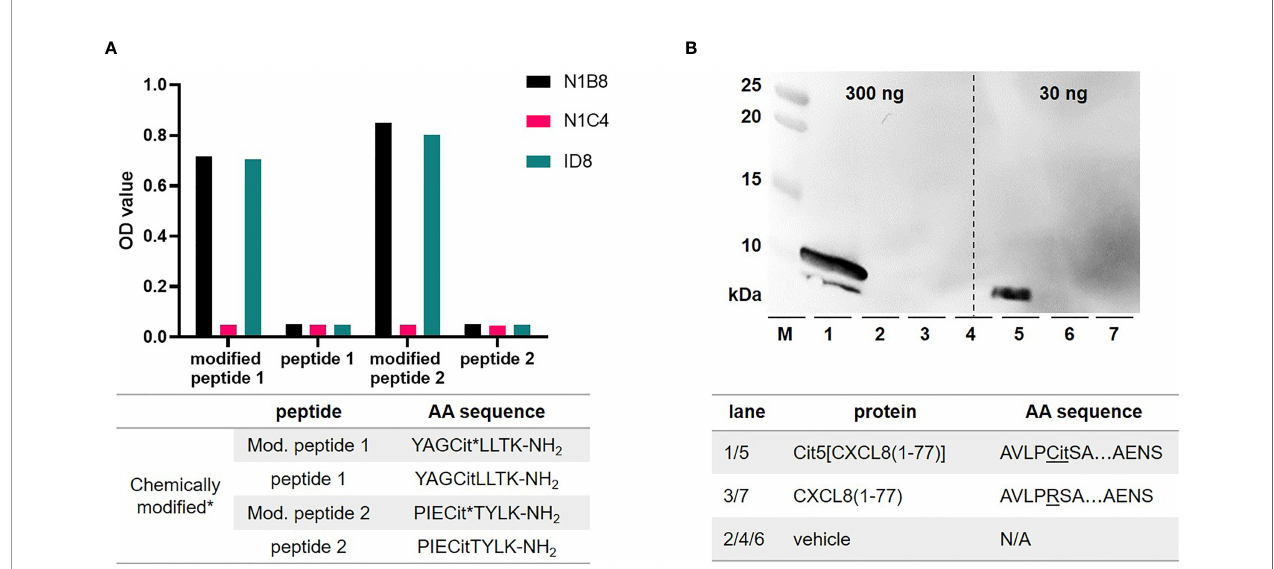
FIGURE 2 | Production and validation of monoclonal anti-modi fi ed citrulline antibodies. Hybridoma clones, both generated from modi fi ed peptide 2, were screened with ELISAs, reactive towards different synthetic citrulline (Cit) containing peptides. These were chemically modi fi ed (* asterisk), and their unmodi fi ed isoforms served as negative controls (A) . Puri fi ed monoclonal antibodies were validated with in-house CXCL8 isoforms. By Western Blot analysis and a protein marker (M) we showed speci fi c detection of citrullinated CXCL8 up to 30 ng and con fi rmed that the monoclonal antibodies did not cross-react with native CXCL8, which lacks citrulline (B) . Amino acid (AA) sequences of respective synthetic peptides are provided in corresponding tables below each panel. Not applicable